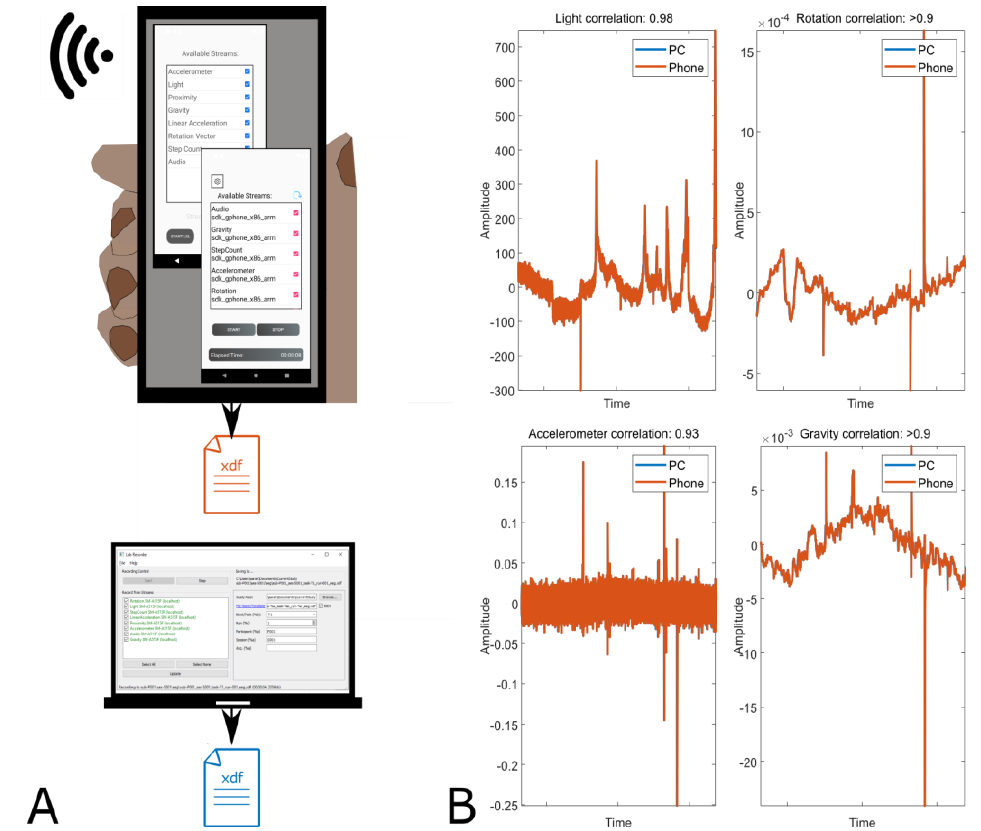
Figure 4. ( A ) Illustration of scenario 3. Both apps, Send-a and Record-a, were running on one phone, streaming and recording sensor data. On PC, LabRecorder was recording all data for validation purposes. ( B ) Selection of sensor data recorded on the PC and on the phone. Shown are 22 minutes of data from one channel per sensor.